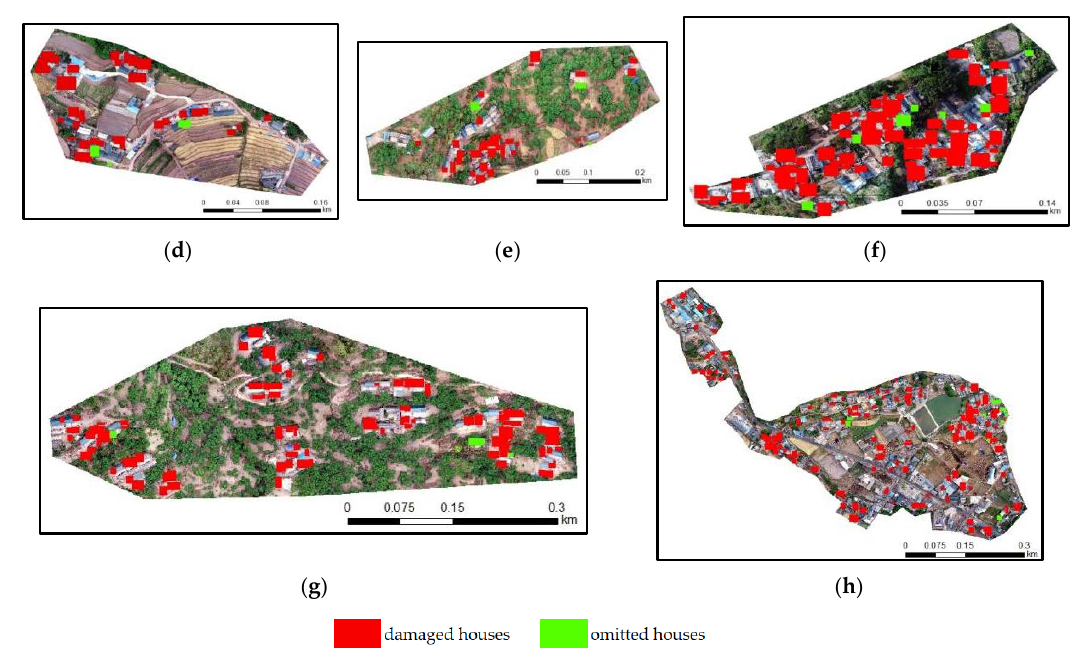
Figure 14. The test results of YOLOv5s-ViT-BiFPN for the 5 test area: ( d ) Baiyang ( e ) Cunwei; ( f ) Baimu; ( g ) Hetaoyuan, and ( h ) Longjing. The red blocks are the damaged houses, and the green blocks are the missing targets.